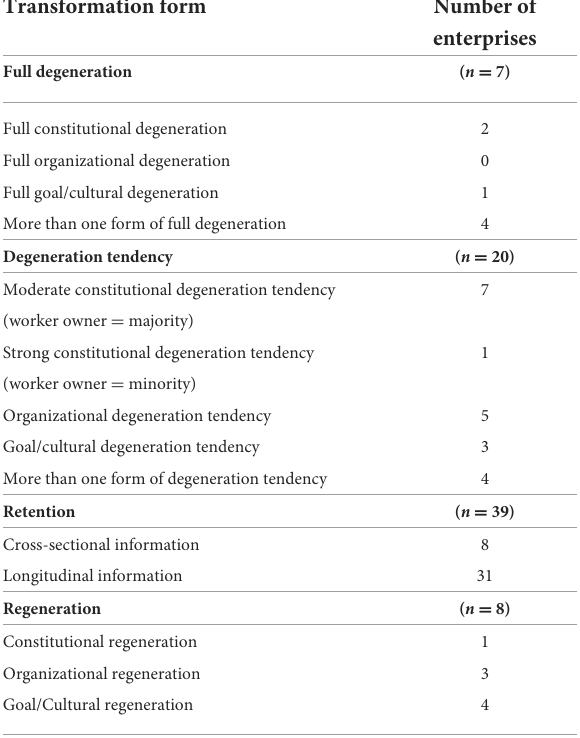
TABLE 1 Number of companies per transformation form (Mondragon Cooperative Corporation is not included). Transformation form Number of